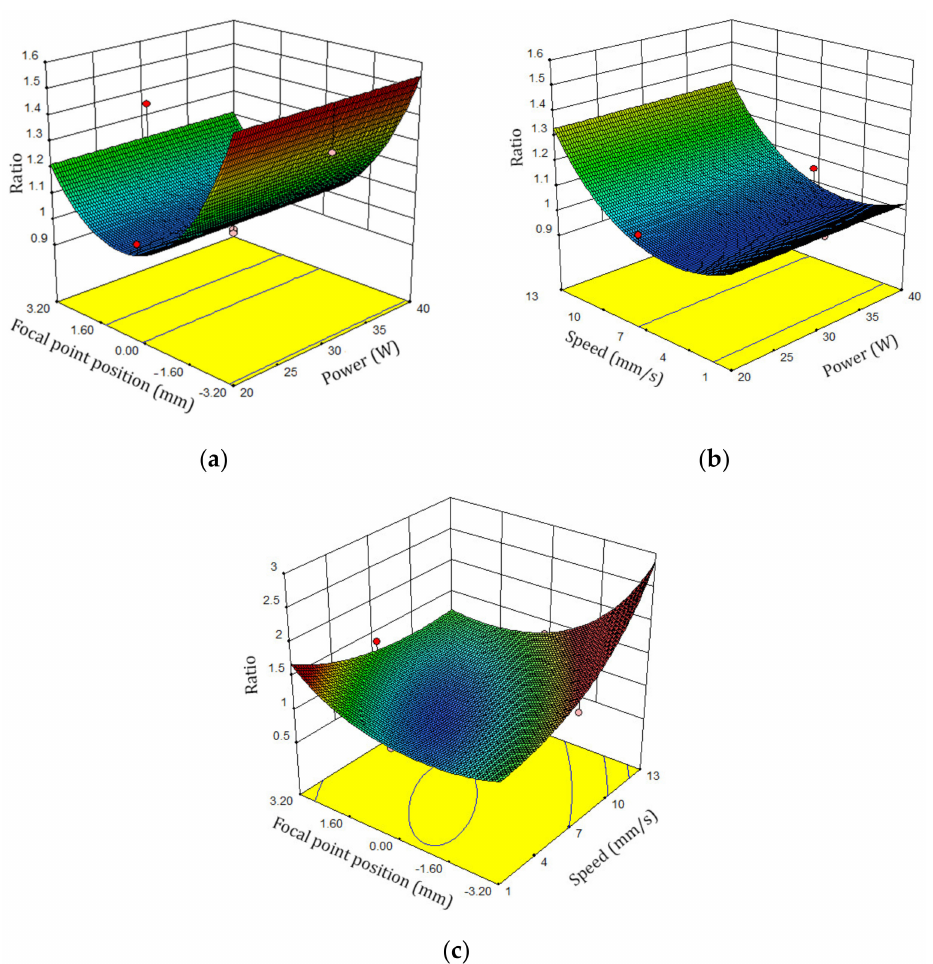
Figure 11. Ratio of top kerf to bottom kerf surface plots: ( a ) FPP and laser cutting speed, ( b ) laser power and laser cutting speed, ( c ) FPP and cutting speed